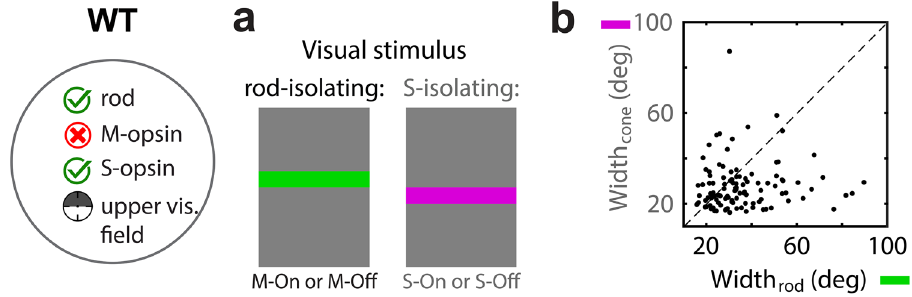
Figure 7. Rod-mediated V1 has larger receptive fields than cone-mediated V1. ( a ) Horizontal bars (6° in vertical width, at 2.8° intervals) were intermittently flashed on the screen, varying in color (M-ON, M-OFF, S-ON, or S-OFF) on constant background light level of ‘b5’ (187 K R*/rod/sec). Data is shown for WT mice, limited to neurons with a receptive field 30-deg above the midline where expression is mostly limited to S-opsin and rhodopsin (n = 108). A Gaussian curve is fit to each neuron’s tuning curve of response vs. bar position, for Rod and S-opsin contrast, which was used to compare receptive field size. Rod isolating contrasts combine responses from both M-ON and M-OFF bars. Cone isolating contrasts combine responses from both S-ON and S-OFF bars. ( b ) Scatter plot compares receptive field width (2σ) between rod (x-axis) and cone (y-axis) isolating contrasts. Each data point represents a single neuron. Unity line is dashed black line. The mean difference is 7.9 visual angle degrees; geometric mean of Width cone /Width rod = 0.83 (t-test: 5.04e −4